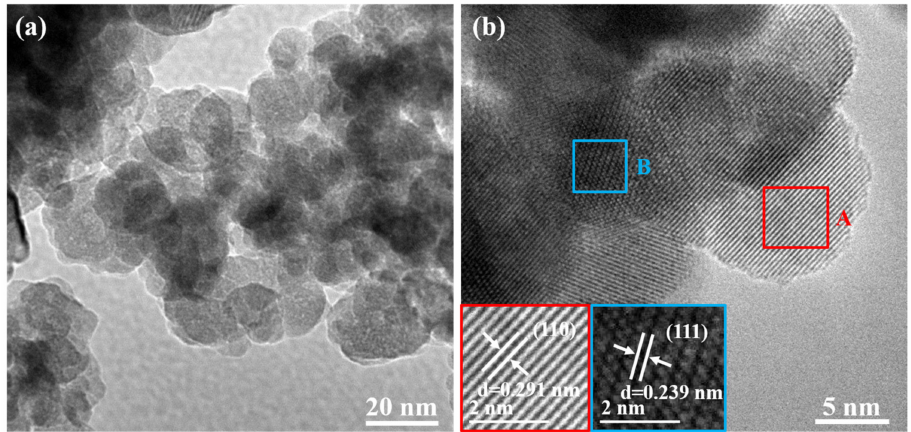
Figure 9. TEM image ( a ), local magnification image ( b ), crystal fringe image A and B of the electro- chemically synthesized BNTO nanoparticles (NaOH concentration is 3.0 mol · L − 1